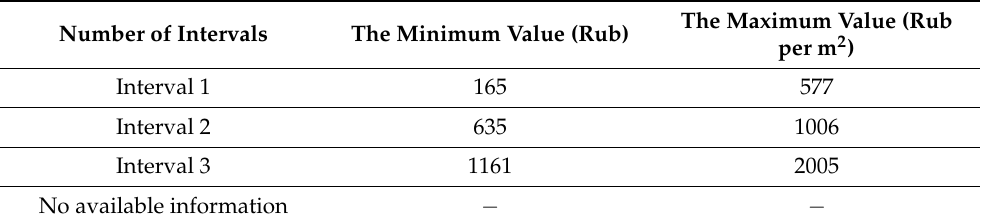
Table 6. Intervals of price levels for land plots for IHC.